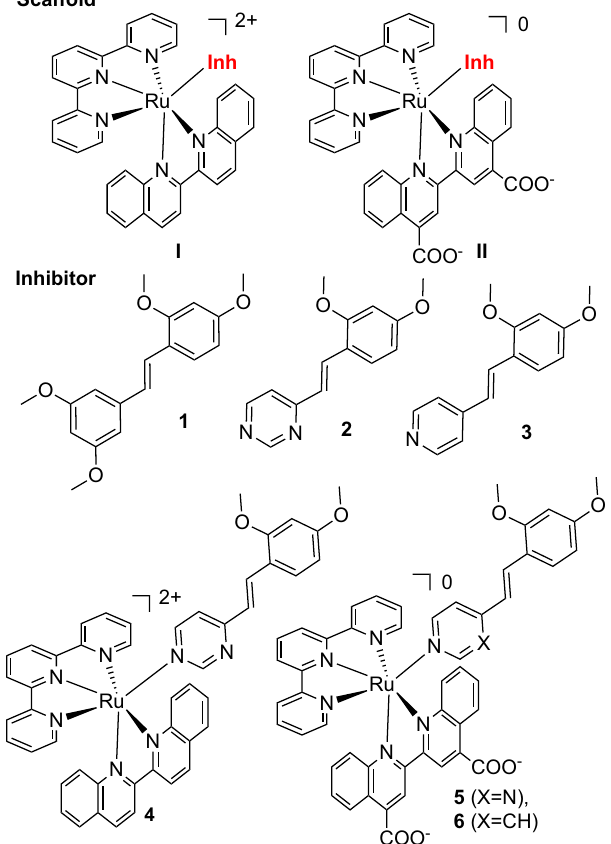
Fig. 1 Ru(II) scaffolds and CYP1B1-selective inhibitors used in this study. Inhibitors 2 and 3 were combined with either Scaffold I or II to give complexes 4 – 6 . Inh =